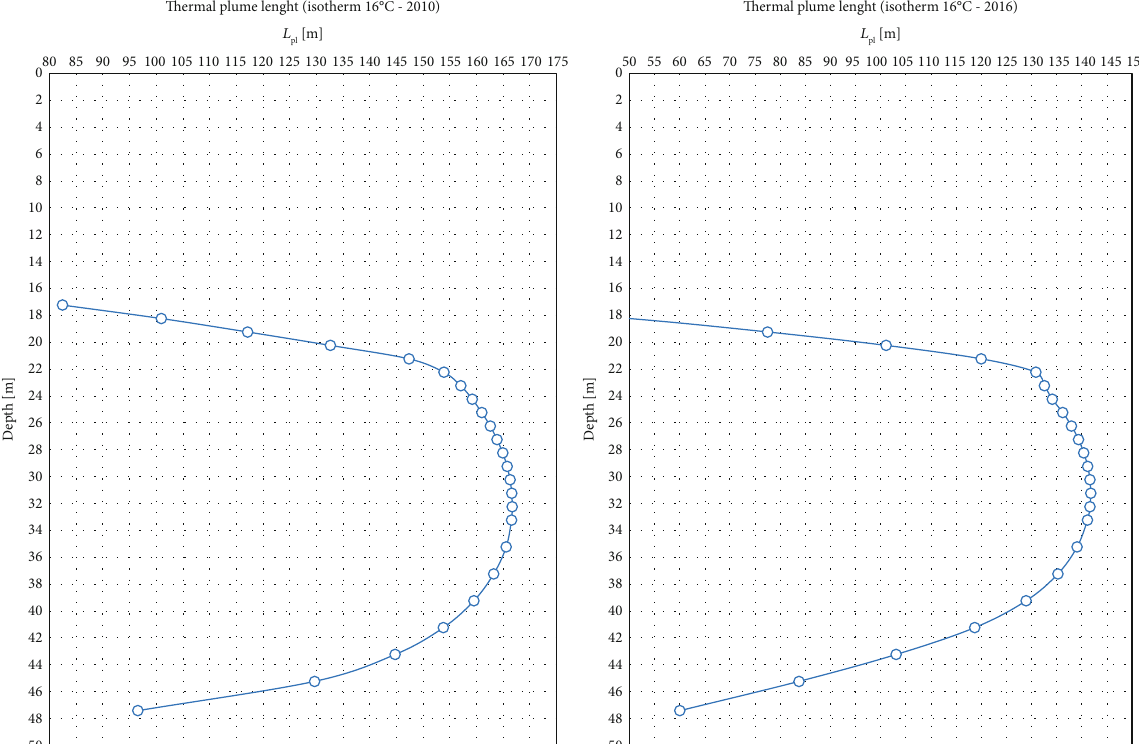
Figure 8: Simulated vertical variation of thermal plume length ( L